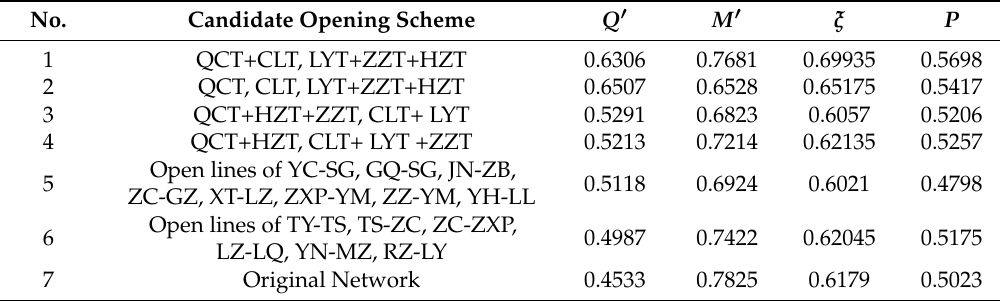
Table 5. Filtering Index and Priority Index of Candidate Schemes.